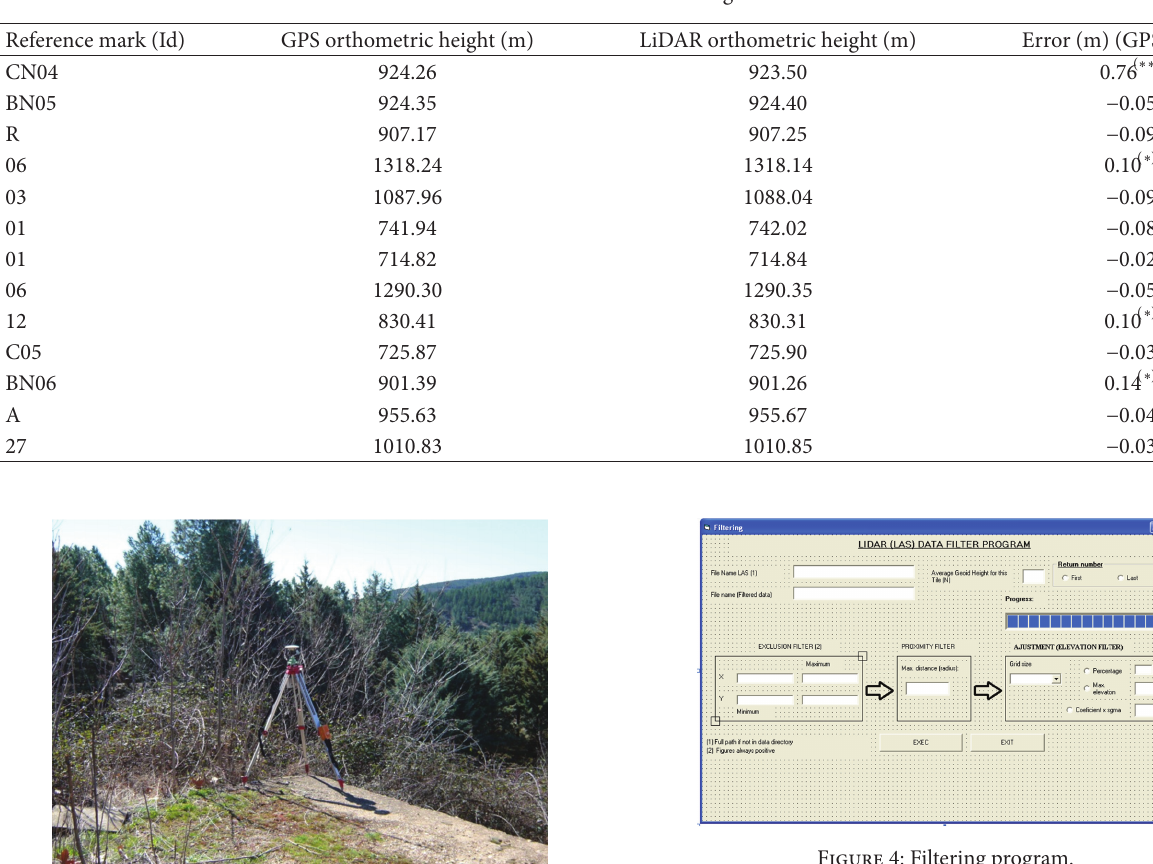
T 2: LiDAR orthometric height errors.